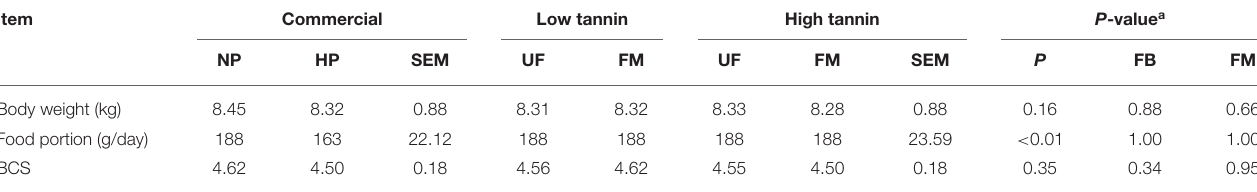
TABLE 1 | Body weight, food portion, and body condition score (BCS) of dogs fed diets formulated with either low or high tannin fava beans without (UF) or with (FM) fermentation, or normal (NP) vs. high (HP) protein commercial diets for 7 days each * .